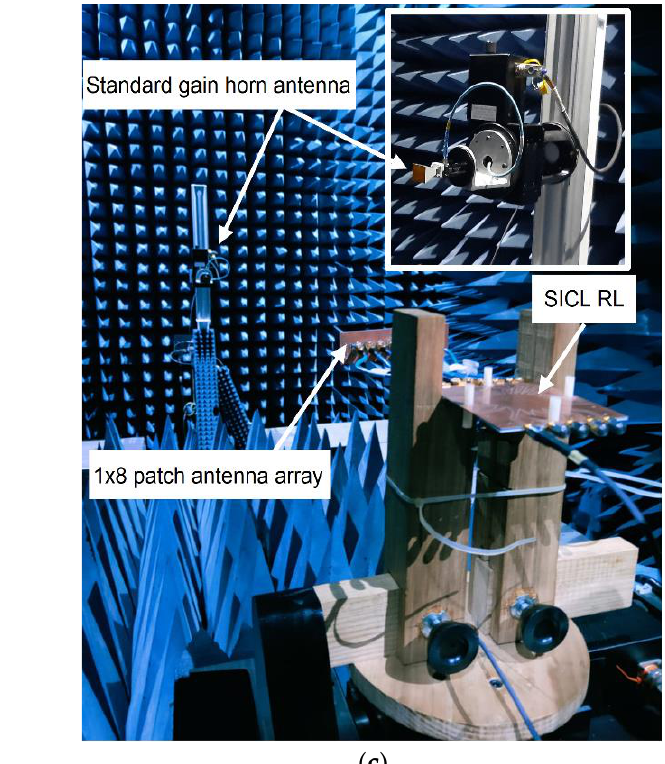
Figure 9. ( a ) Fabricated SICL Rotman lens (upper conductor layer removed); ( b ) integration with 1 × 8 antenna array; ( c ) test fixture in Anechoic Chamber for radiation pattern measurements.